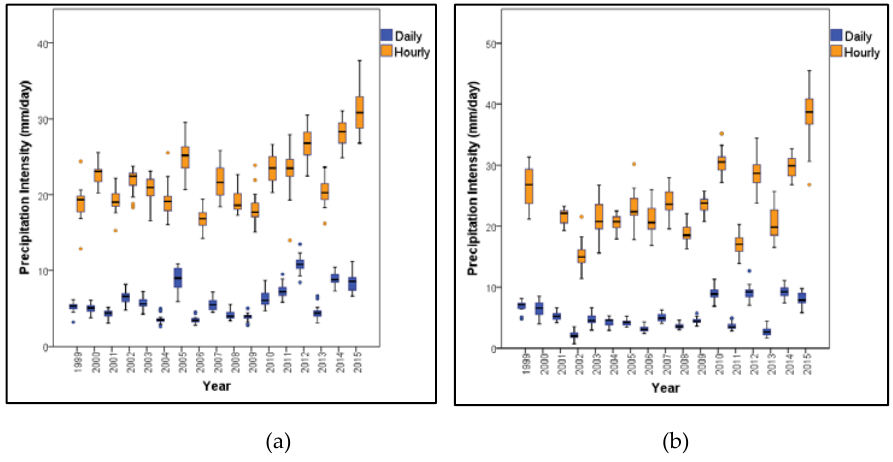
Figure 6. Daily and hourly precipitation intensities for all years and stations for March ( a ) and October ( b ). The box shows 50% of the data, with median represented as a black bar. The whisker extends to two standard deviations of the data, and circles represent